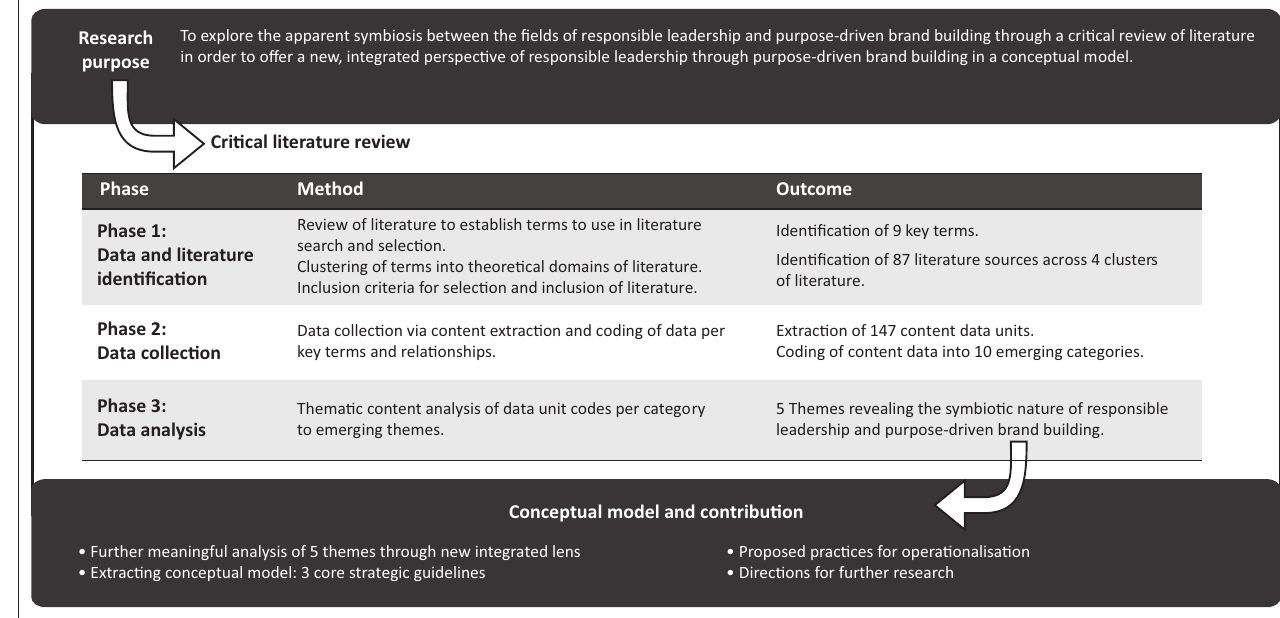
FIGURE 1: Synopsis of the